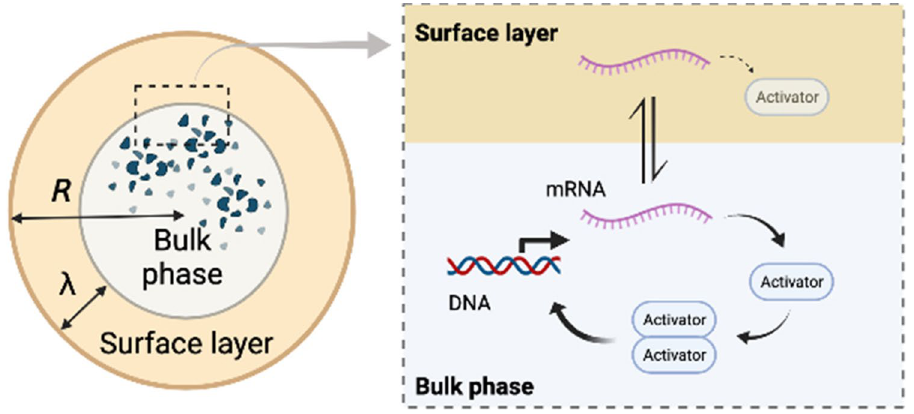
Figure 4. Schematic illustration of the TXTL reaction with positive autoregulatory feedback (PAF) control. The activator protein synthesized by the TXTL reaction forms a dimer at equilibrium constant K 3 . The activator dimer binds to the operator region at equilibrium constant K 4 . PAF control upregulates mRNA synthesis. Figure was created with